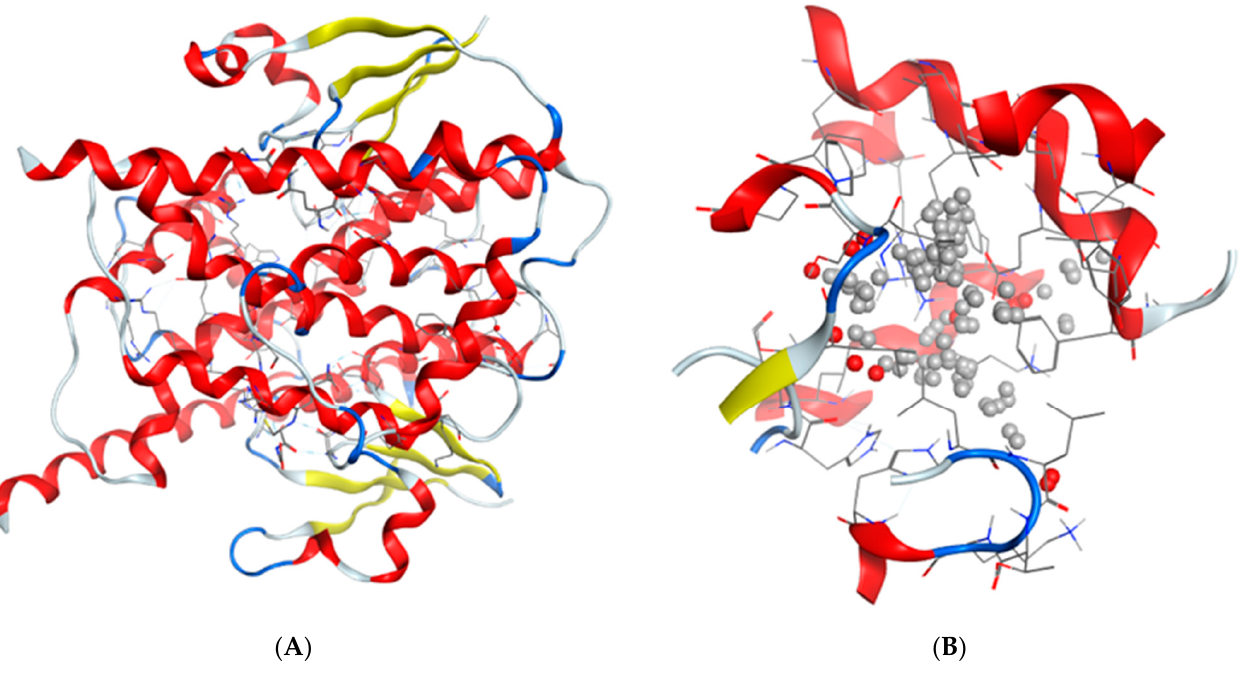
Figure 2. Protein 5FT3 ( A ); largest pocket 5FT3 ( B ).